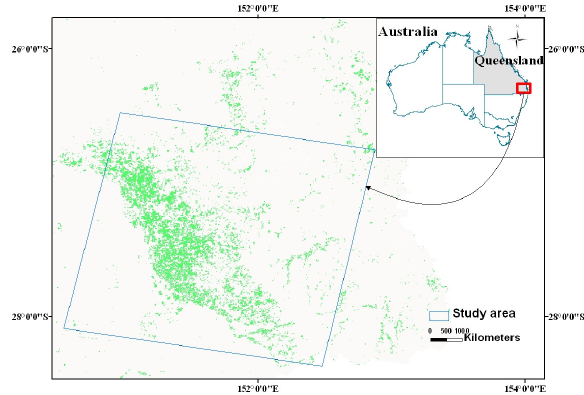
Figure 2. Segmenation of Landat image using eCoginition. Yellow lines indicate segment delineation. The images is visualised as false colour composite by projecting near infrared, red and green bands as red, green and blue,